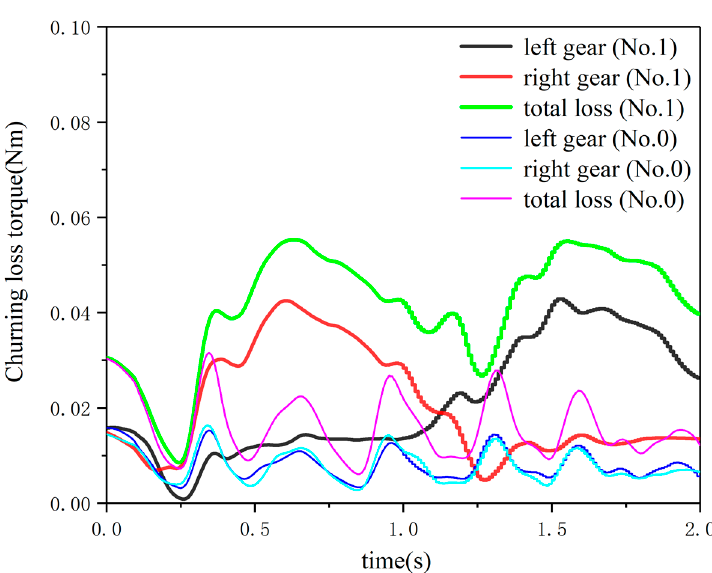
Figure 6. Time history curves of churning loss torques of parameter combination No. 0 and No. 1.